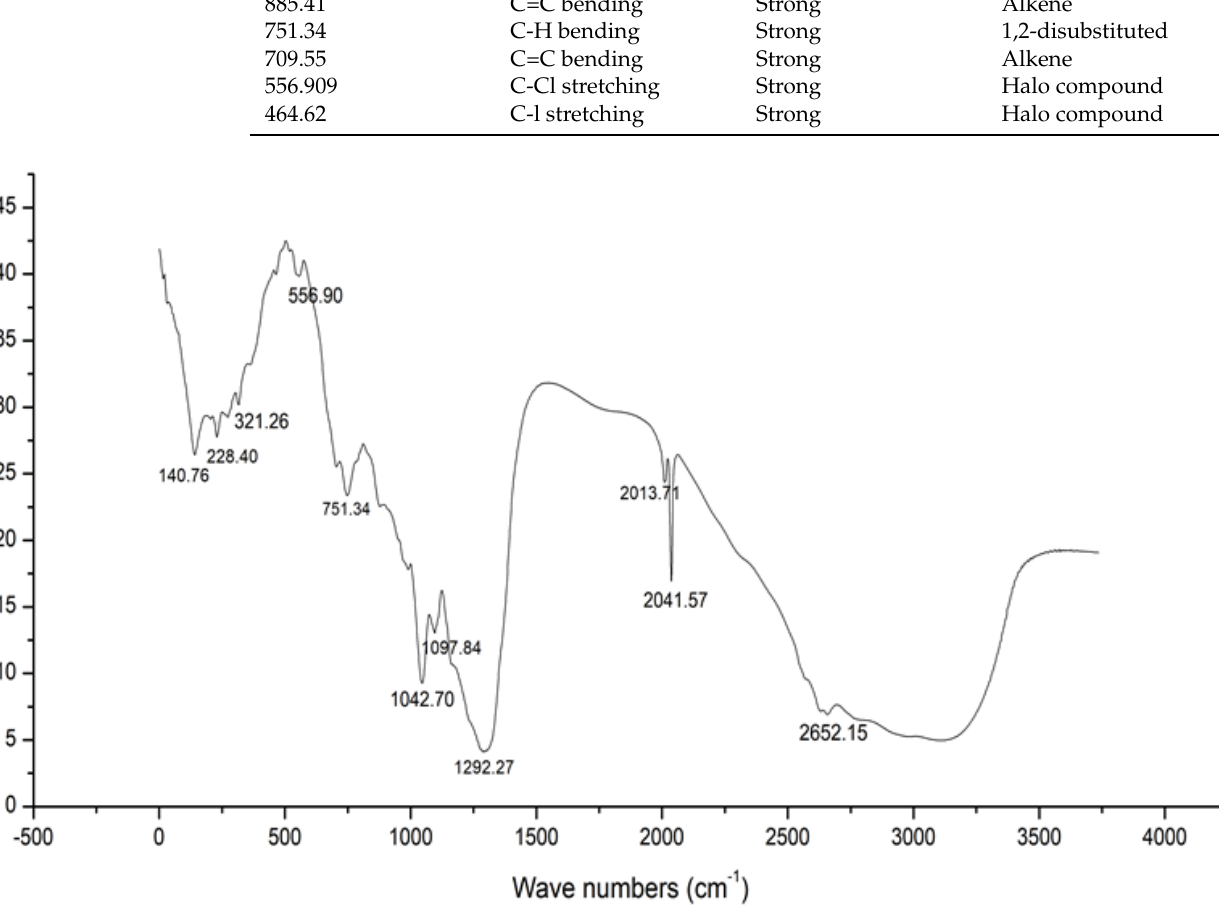
Table 3. FTIR analysis of compounds exhibiting their functional groups.